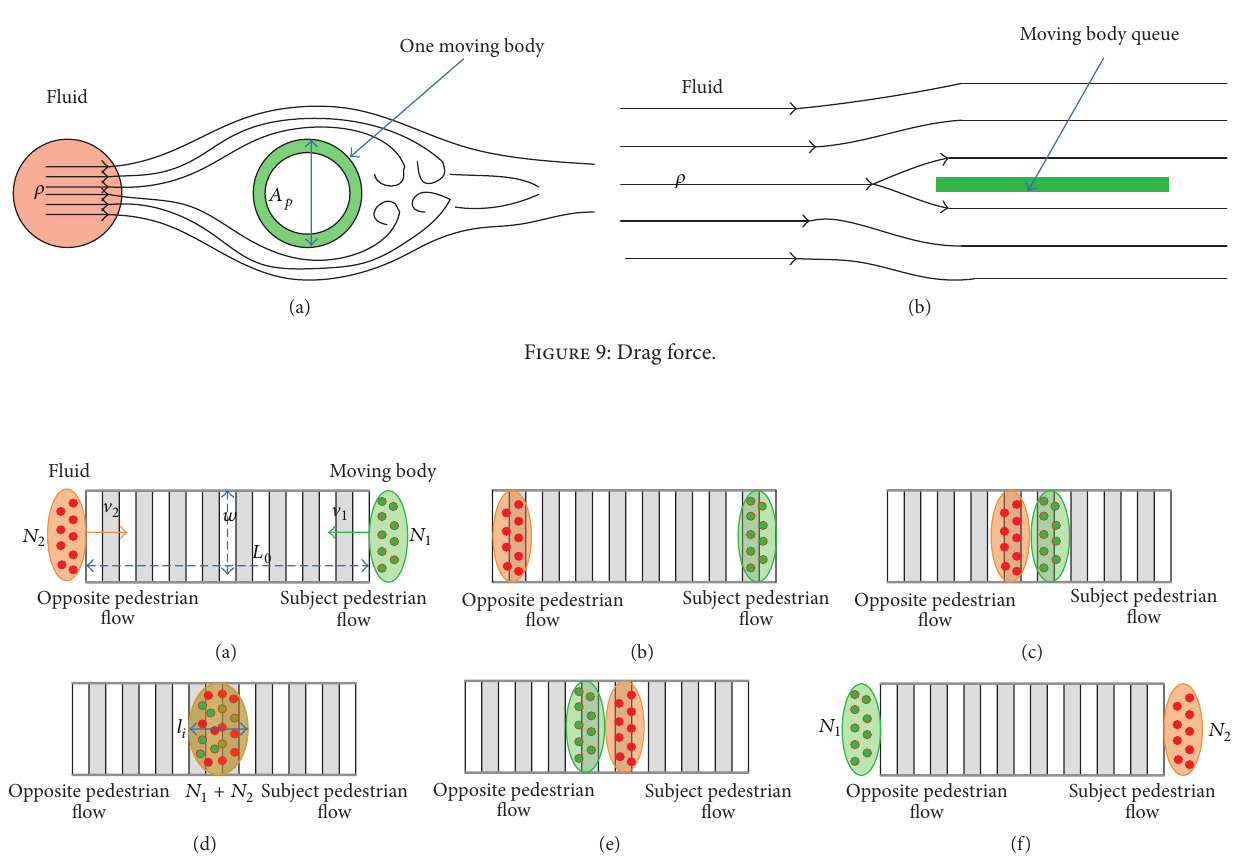
Figure 10: Diagram of process for a platoon of pedestrians crossing the crosswalk. 𝑤 : crosswalk width (m); 𝑁 1 : number of subject pedestrians; 𝑁 2 : number of opposite pedestrians; 𝑙 𝑖 : maximum interaction length (m).